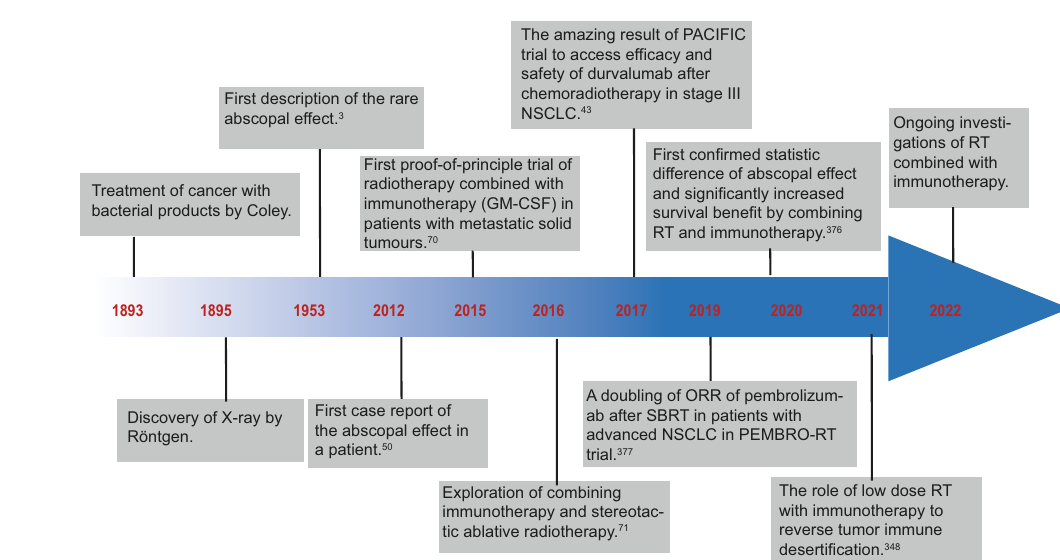
Fig. 1 Historical timeline of some important developments regarding the